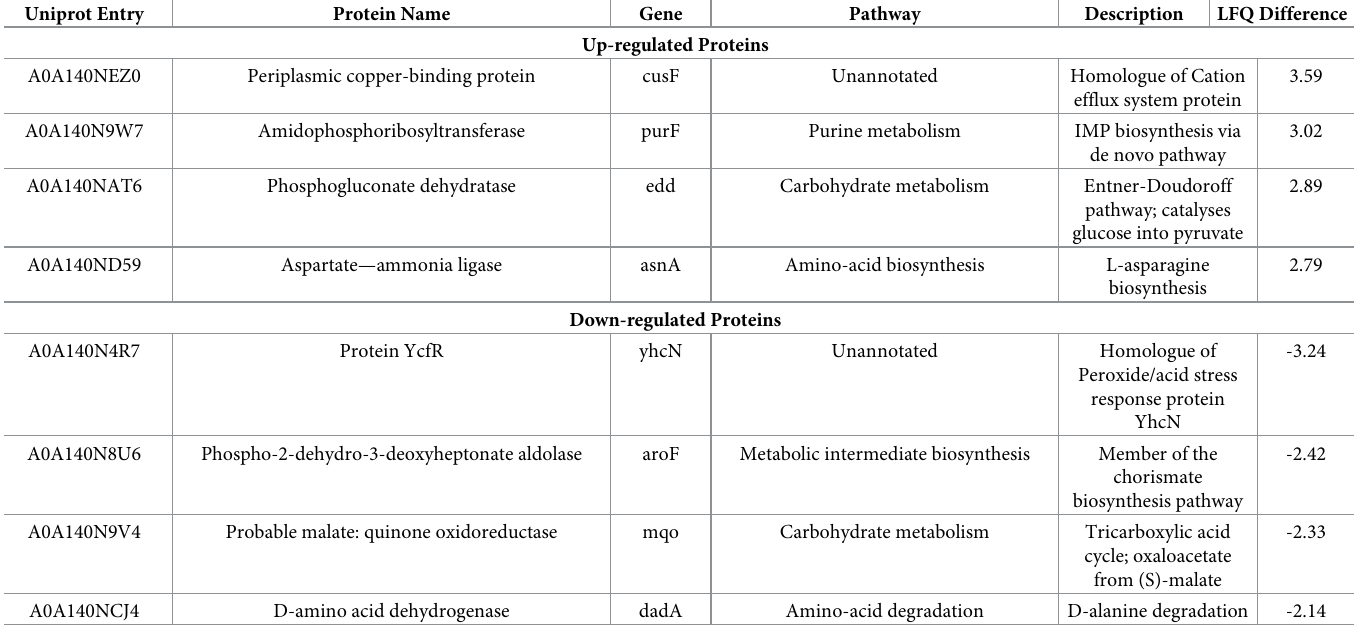
Table 1. Most significantly dysregulated E . coli proteins and the associated annotated functional pathway. Proteins highlighted by accession number in Fig 4 are described here with one example of an upregulated and downregulated protein lacking an annotated functional